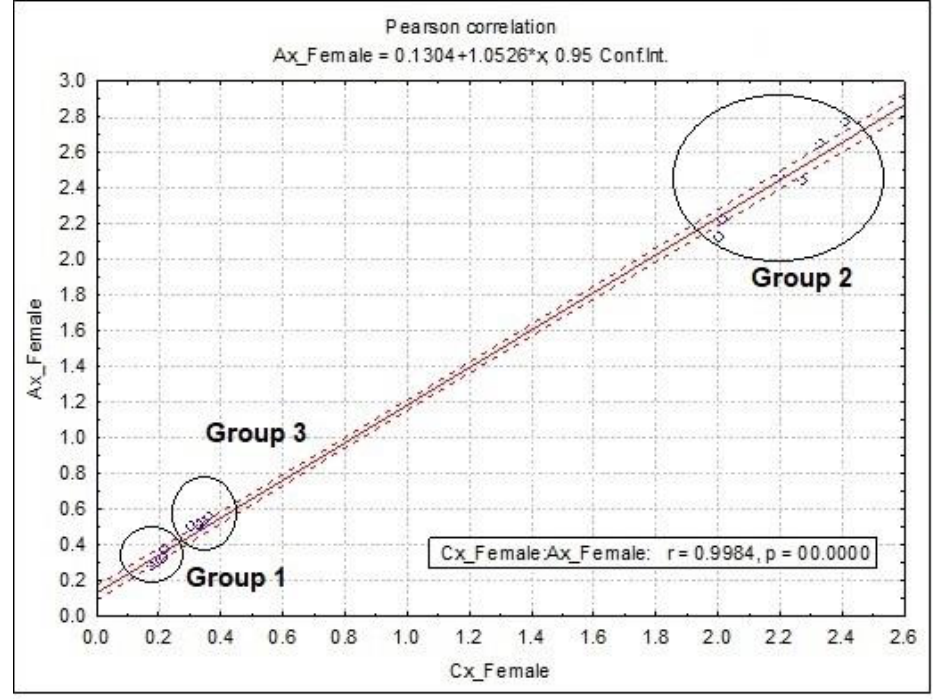
Figure 5. Pearson correlation between Ax and Cx accumulation in the female gonads of rainbow trout, O. mykiss .